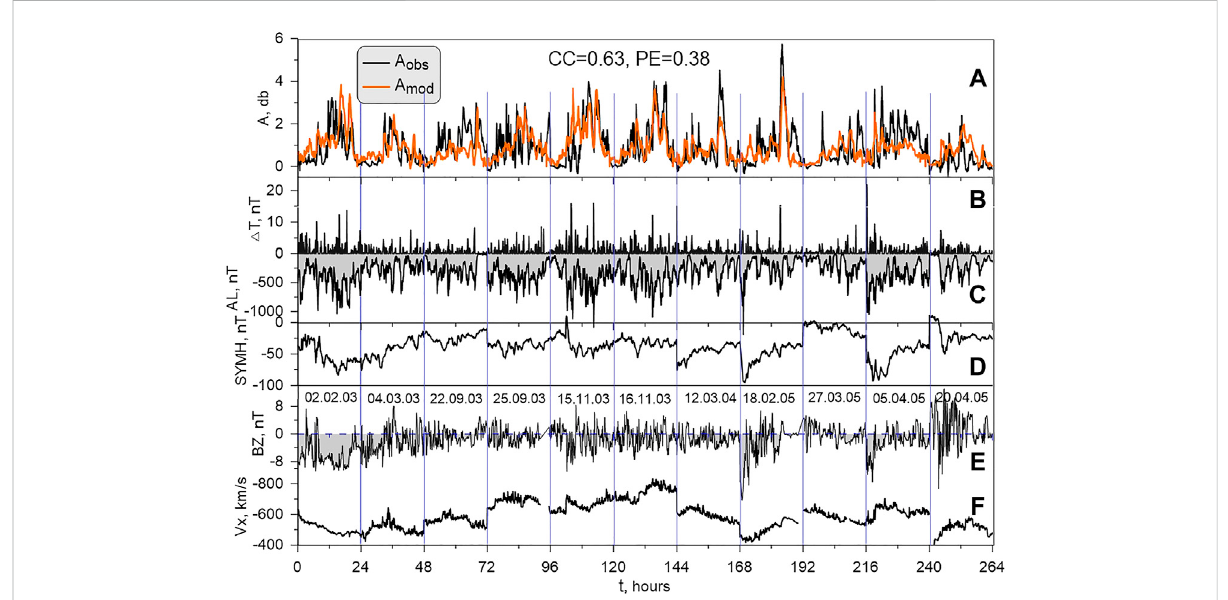
FIGURE 1 Stackplots ofvariablesduring selected 11full-dayactiveperiodsat5 minresolution.From toptobottom: (A) -absorptionvaluesobserved atISL (black) compared with predicted absorption values (orange trace); (B) - dipolarization intensity estimated from MPB index, used to drive the model; (C,D) AL and SYMH indices for these days; (E) - IMF B Z , (F) - solar wind velocity. Dates are indicated in panel (E)